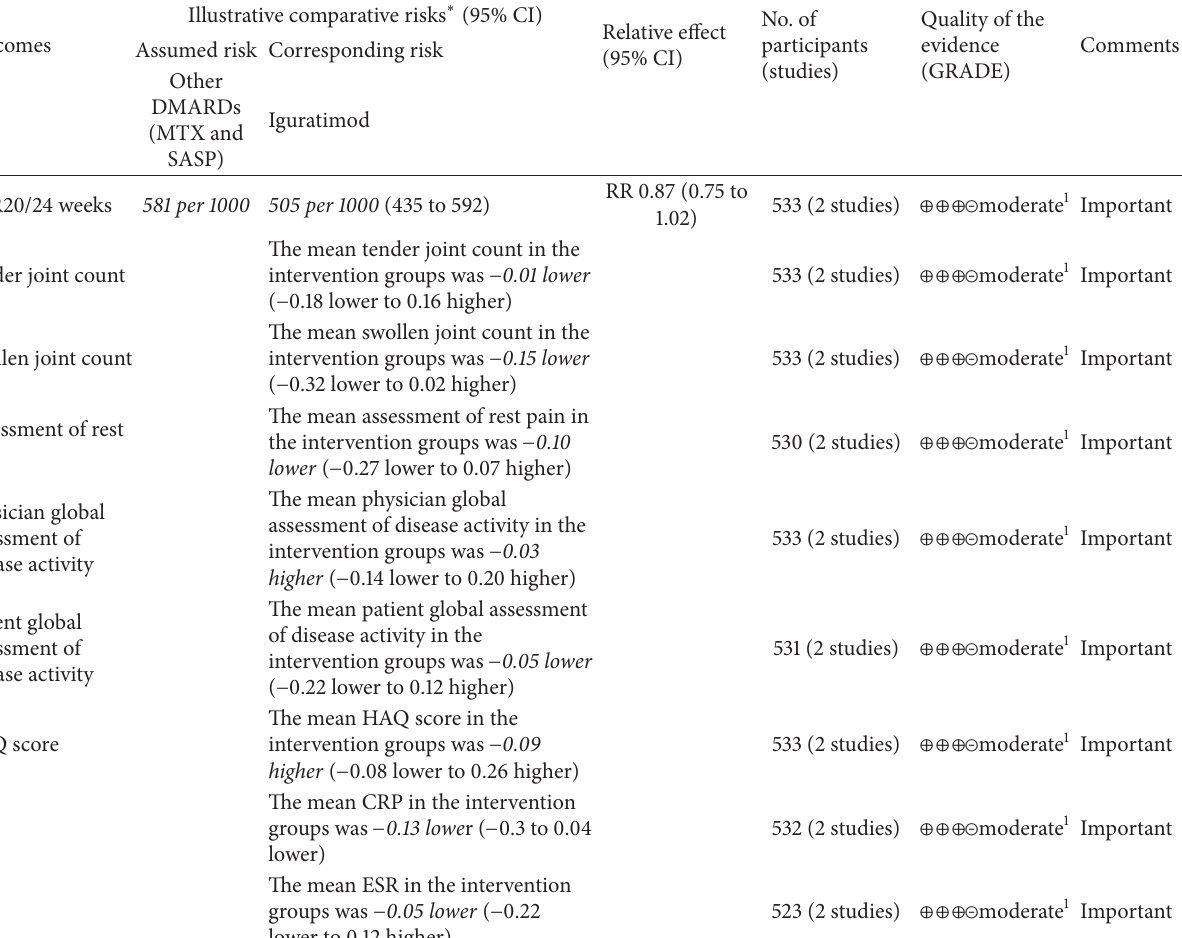
Table 3: Summary of the findings for the main comparison: iguratimod compared to the other DMARDs (MTX and SASP) for rheumatoid